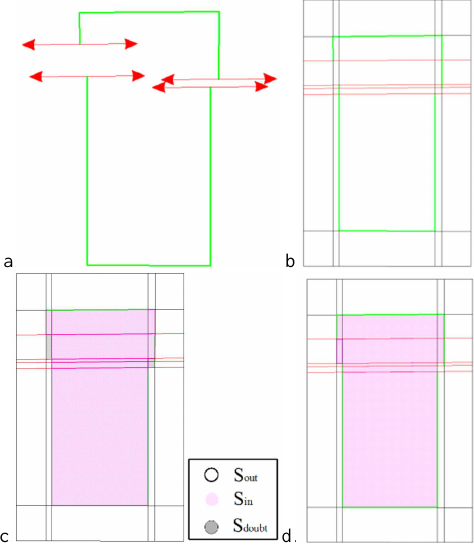
Figure 5. Cell complex construction and labelling for ‘Classroom’ data set: (a) detected primitives with ‘ pending’ walls; (b) induced cell complex ; initial (c) and final (d) labelling of the cell complex